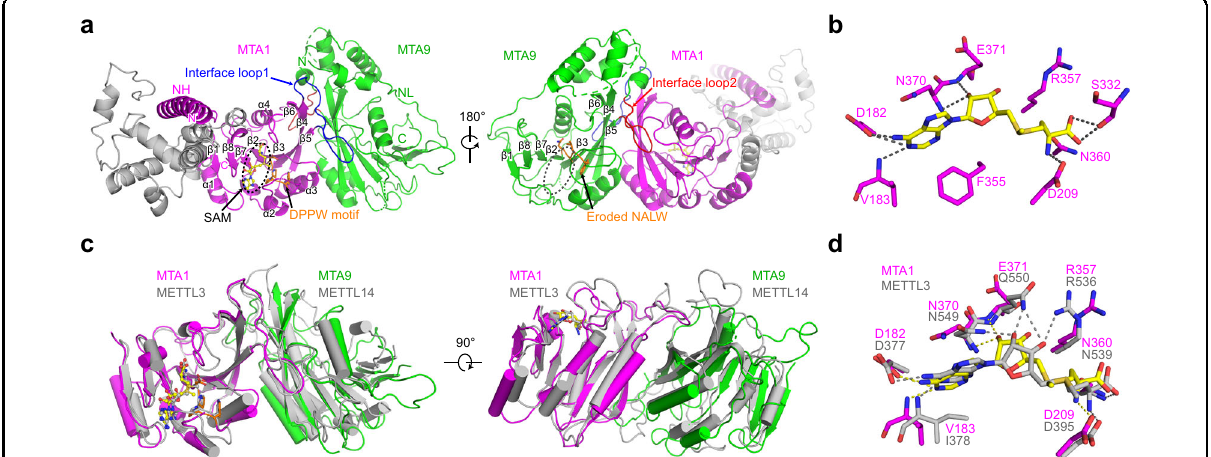
Fig. 2 Structural analysis of MTA1 – MTA9 in the MTA1 complex. a Overall structure of MTA1 – MTA9 in the MTA1 complex. MTA1, magenta; MTA9, green; MTA1 interface loop 1, blue; MTA9 interface loop 2, red. The bound SAM is illustrated as a yellow ball-and-stick surrounded by a dashed ellipse. The DPPW motif and the eroded NALW motif are shown as orange sticks. b Schematic representation of the interactions between MTA1 and SAM. Residues are shown as magenta sticks. SAM is shown as yellow sticks. Hydrogen bonds are shown as black dashed lines. c Superposition of the core MTase domains of MTA1 – MTA9 (magenta and green) and METTL3 – METTL14 (gray). The bound SAM in MTA1 and METTL3 are shown as yellow and gray balls-and-sticks, respectively. The DPPW motifs in MTA1 and METTL3 are shown as orange and gray sticks, respectively. d Superposition of the SAM molecules and the SAM interacting residues in MTA1 and METTL3, with the same color scheme as c . Hydrogen bonds in MTA1 and METTL3 are shown as yellow and gray dashed lines,